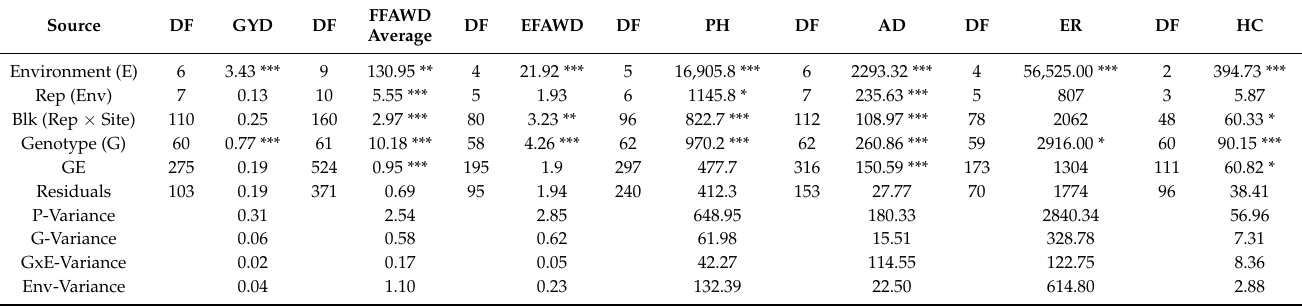
Table 4. Analysis of variance for fall armyworm damage scores and agronomic traits of inbred lines evaluated across natural fall armyworm infestation sites during the 2019 and 2020